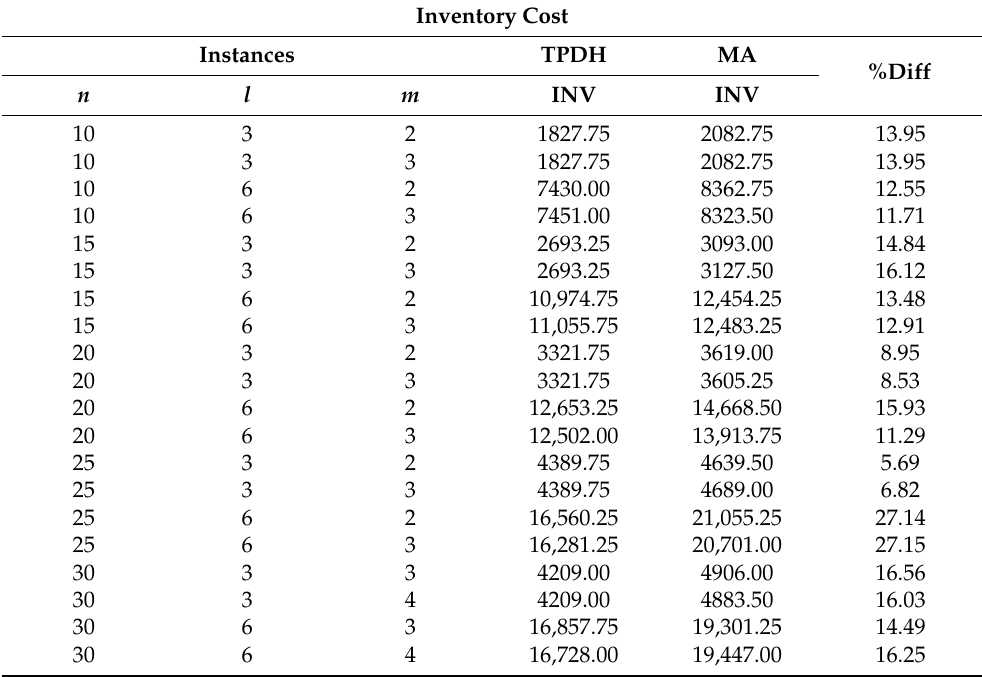
Table 19. Comparison of total inventory